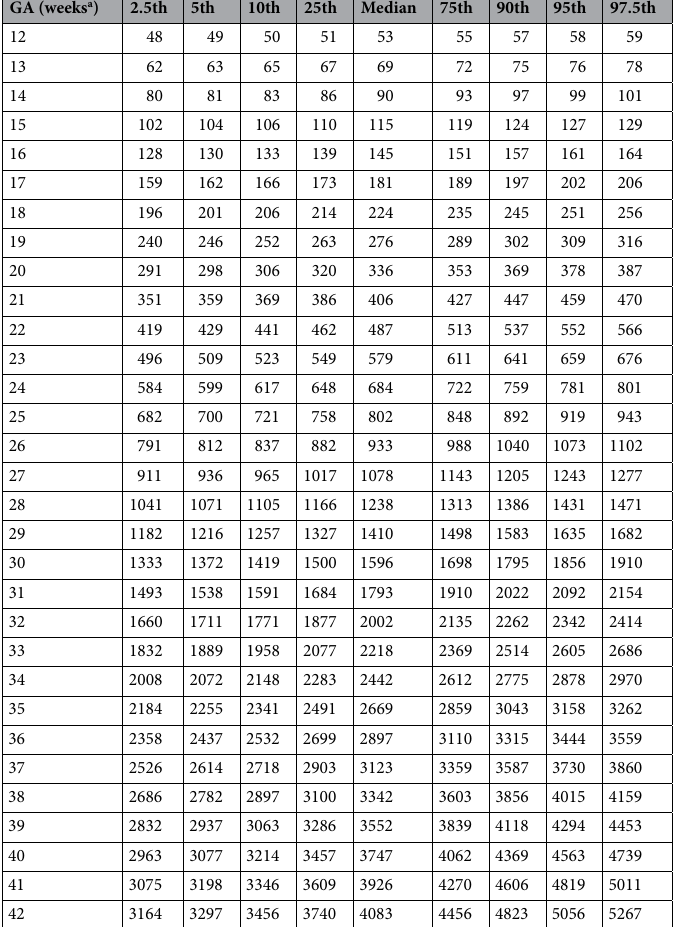
Table 3. Medians and percentiles of estimated fetal weight in grams by gestational age (GA) for male and female fetuses. a GA expressed as completed gestational weeks, e.g. 12 weeks corresponds to 12 + 0 weeks or 84 gestational